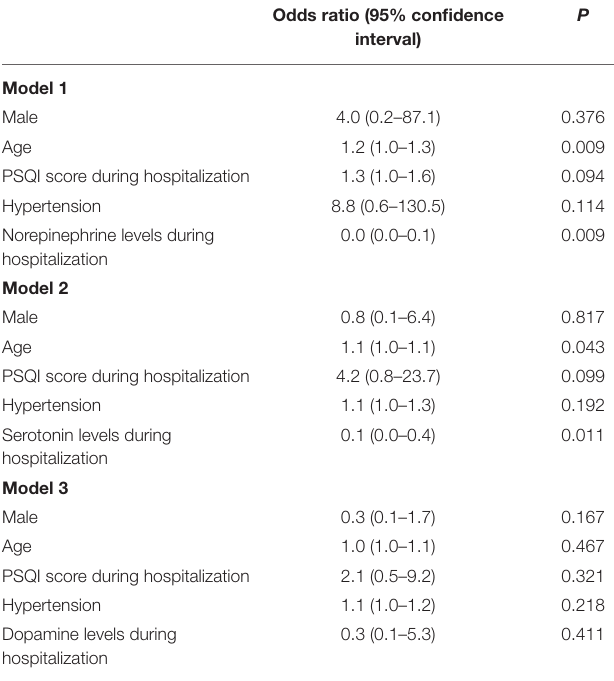
TABLE 2 | Multivariable analysis of fatigue after mild ischemic stroke during hospitalization.